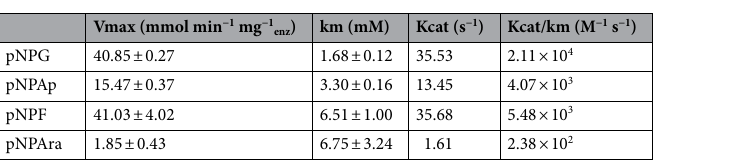
Figure 5. Biochemical characterization of ThABF. Relative activity of the recombinant protein at temperatures of 20 to 70 °C ( a ) and in the pH range of 4 to 10 ( b ). Enzymatic kinetics of TiBgal54A with the substrates pNPG ( c ) and pNPA ( d ).